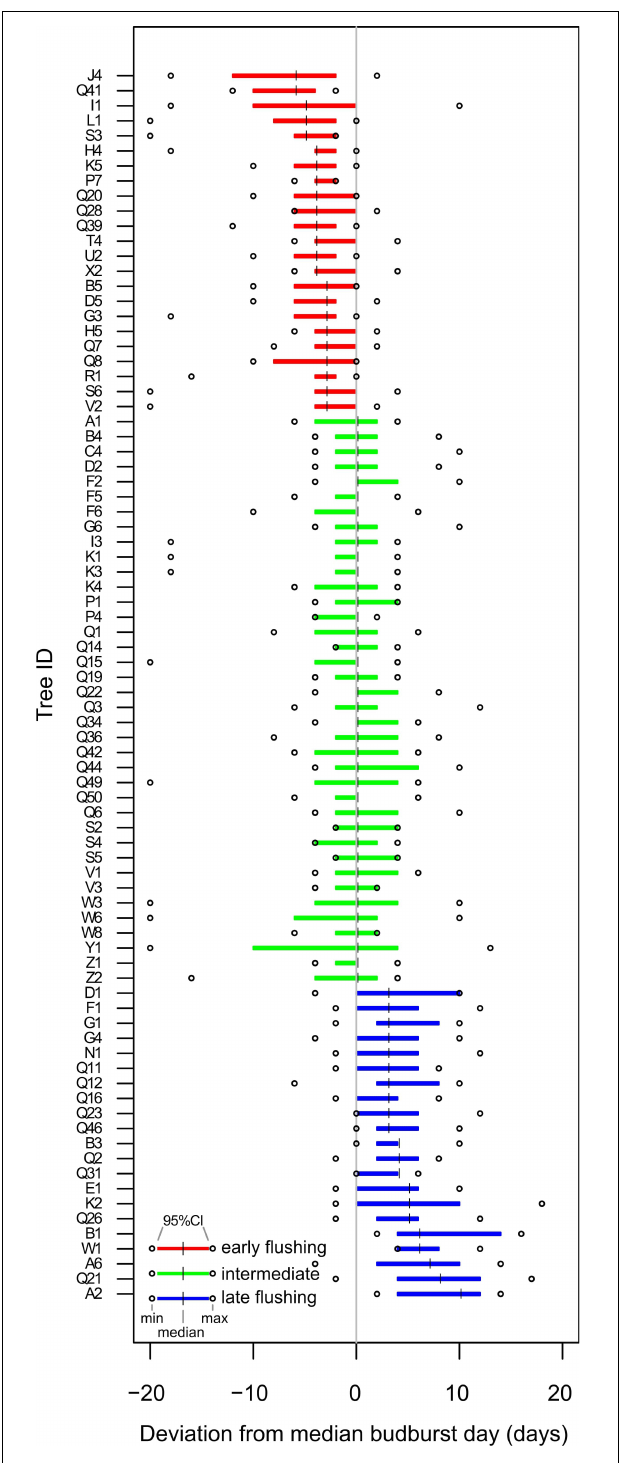
FIGURE 1 | Temporally consistent phenological groups in a beech forest in Serrahn. All observed trees and their respective median deviation from the median tree across the 12 years of observations. Colors indicate the three phenological groups. Displayed are 95% CIs of the median deviation of each tree from the median tree. Dots represent tree-specific minimum and maximum median deviations across the 12